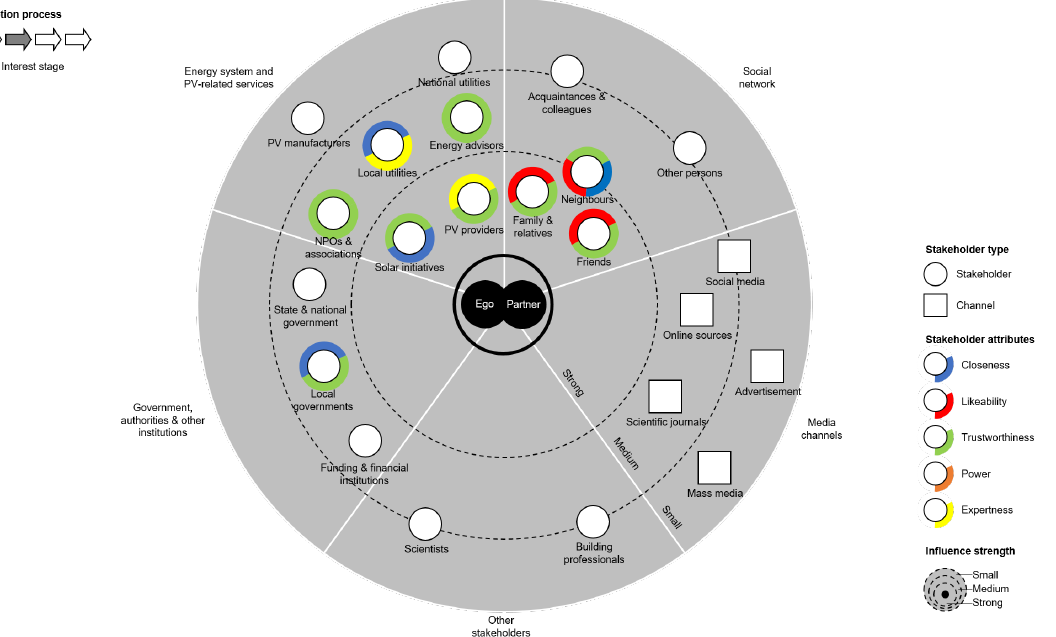
Figure 4. Visual representation of the egocentric network of the stakeholder dynamics at the interest stage. The focus is on residential PV adoption from the perspective of the household decision-maker (own